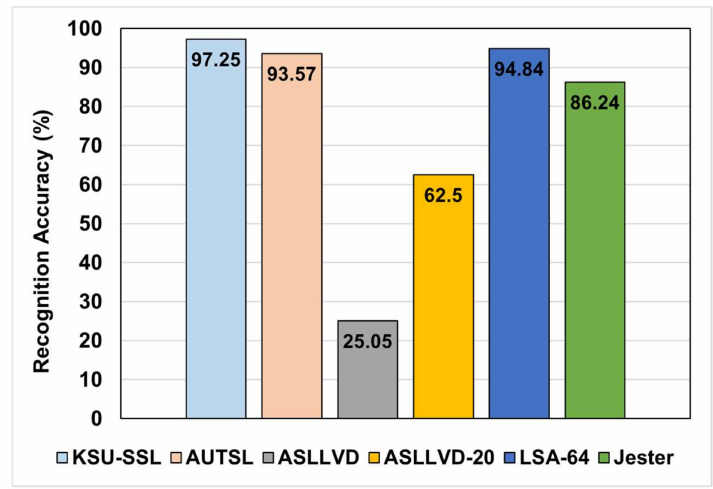
Figure 8. Enhanced architecture accuracy on different